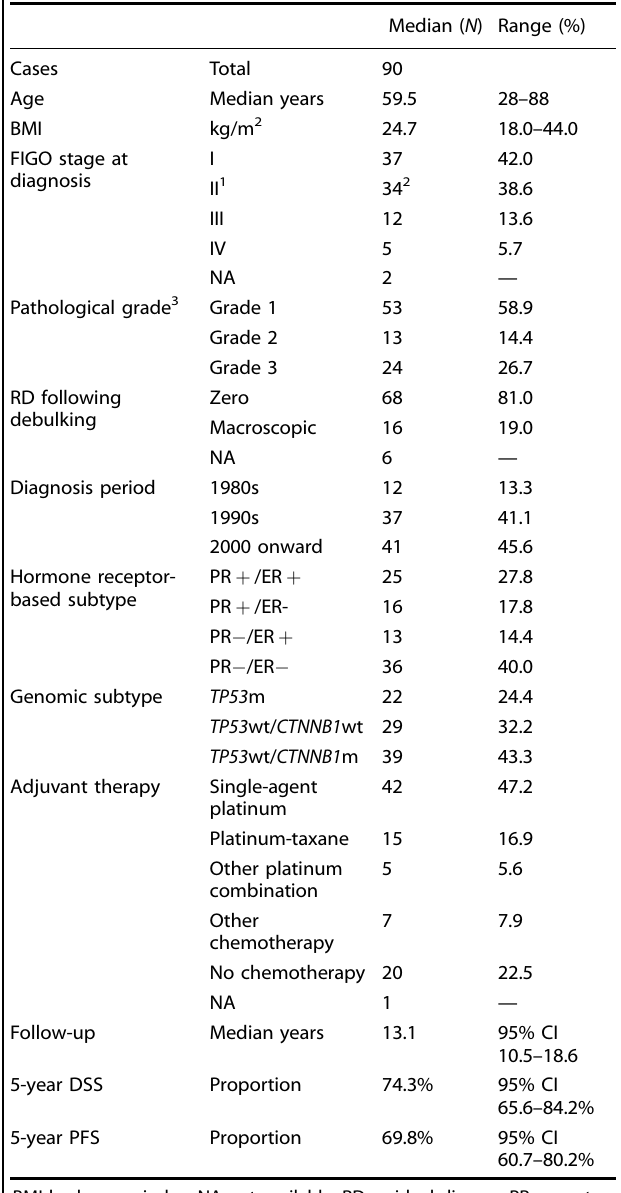
Table 1. Characteristics of 90 endometrioid ovarian carcinoma